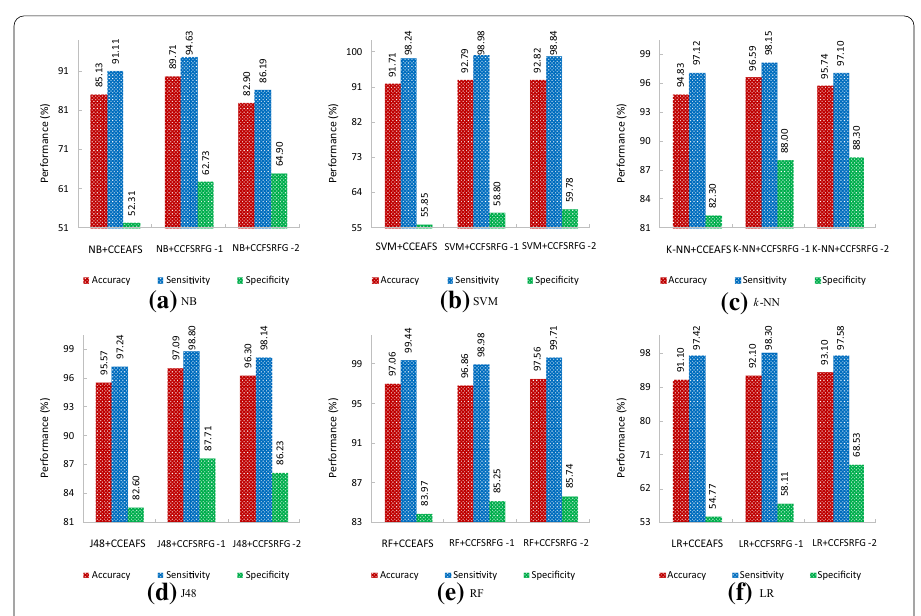
Fig. 9 Performance evaluation of classifiers on the Musk